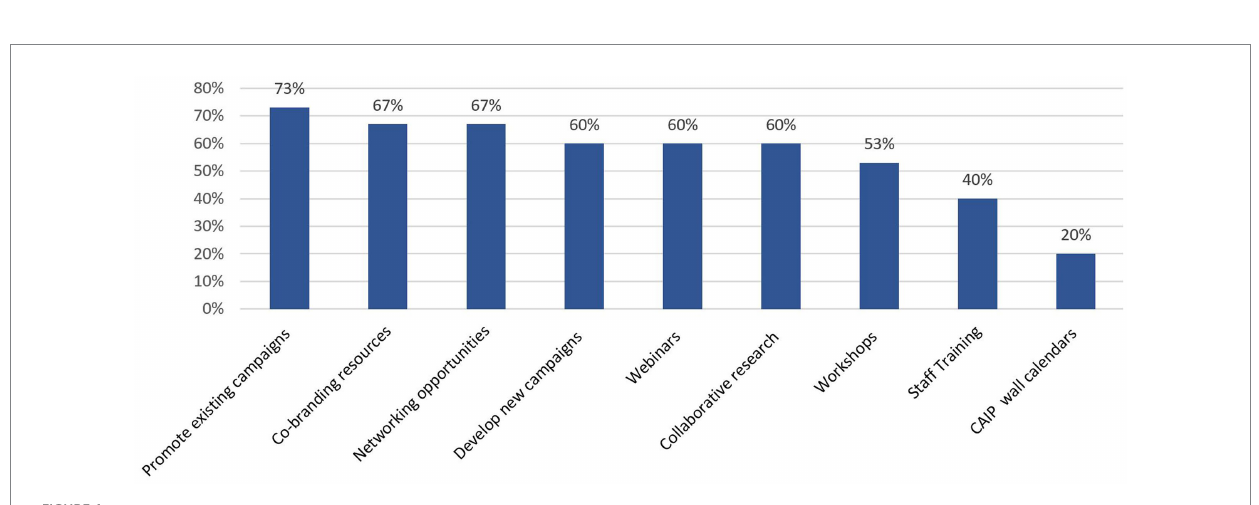
FIGURE 4 CASN member interest in CAIP